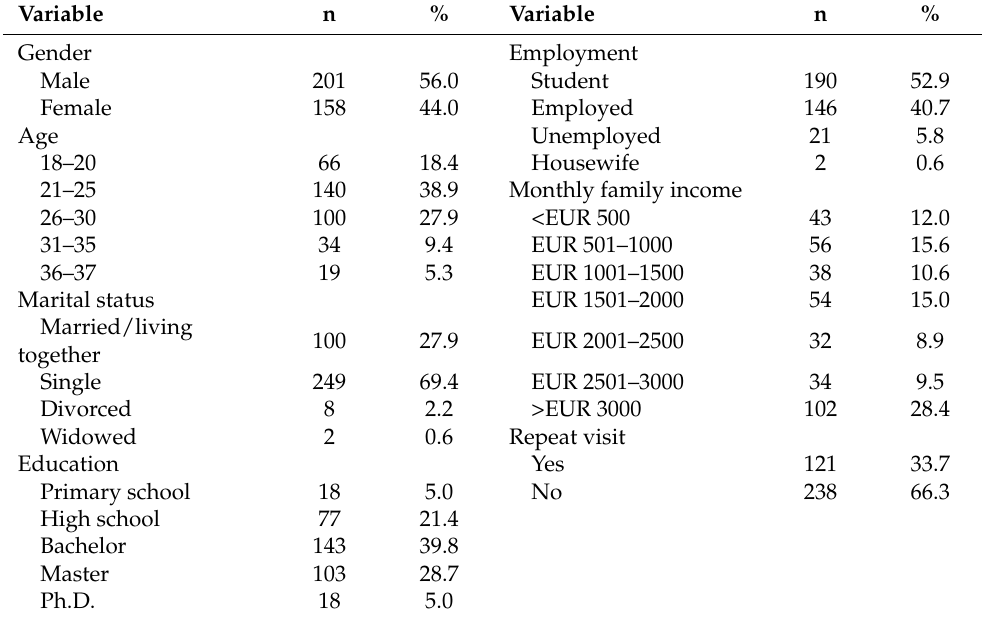
Table 1. Socio-demographic characteristics and previous visits of